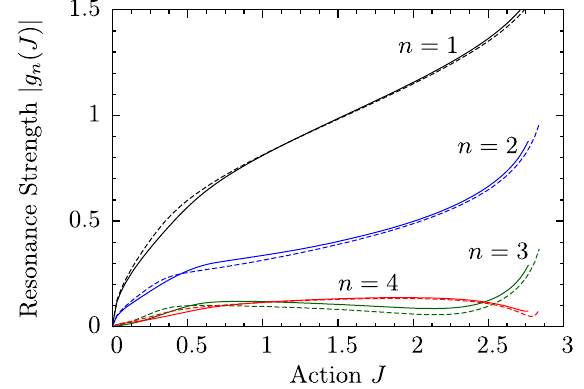
ð J Þj as func- n ¼ 45 o